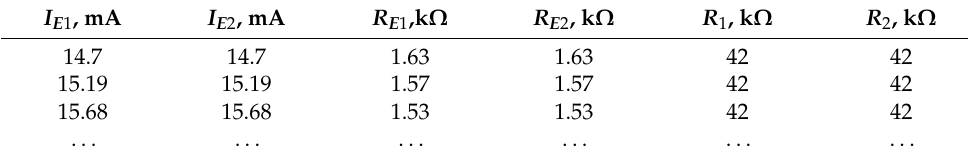
Table 4. Parameters of intermediate stage.